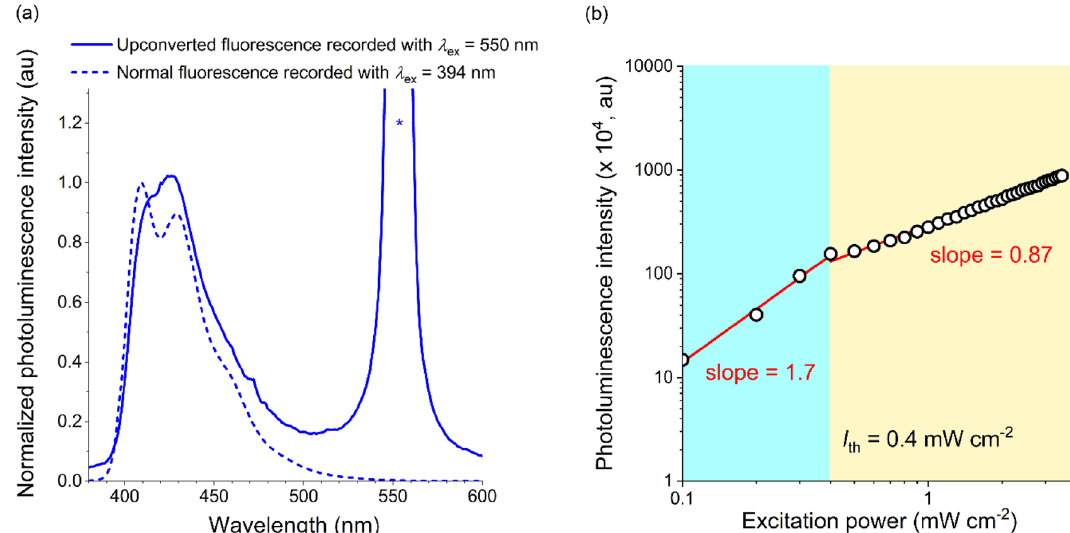
Figure 2. Upconverted fluorescence emission from TTA-UC nanoparticles. ( a ) Photoluminescence spectra of the TTA-UC nanoparticle (i.e., PtOEP:DPA@PS nanoparticle) suspension (milli-Q water) recorded upon the photoexcitation of PtOEP at a wavelength of 550 nm (solid line) and the direct photoexcitation of DPA at a wavelength of 394 nm (dashed line). The peak marked with an asterisk is the 550 nm excitation beam. ( b ) A double-logarithmic plot of the photoluminescence intensity as a function of the excitation power. The sky-blue and the yellow regions indicate upconverted fluorescence where the bimolecular TTA and the unimolecular radiative decay of DPA